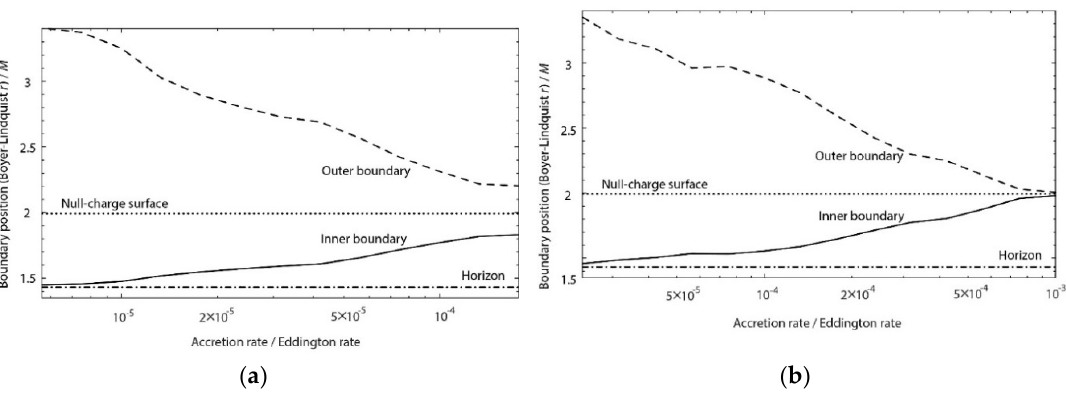
Figure 16. Spatial extent of the gap along the polar axis, θ = 0 ◦ , as a function of the dimensionless accretion; a = 0.9 M is assumed. Thick solid and dashed curves denote the position of the inner and the outer boundaries of the gap, respectively, in units of the gravitational radius, r g = M . These boundary positions (in the ordinate) are transformed from the tortoise coordinate into the Boyer–Lindquist coordinate. The horizontal dot–dashed line shows the horizon radius, whereas the horizontal dotted line shows the null surface position. ( a ) The case of M = 10 9 M ʘ . ( b ) The case of M = 10 6 M ʘ . From [68].